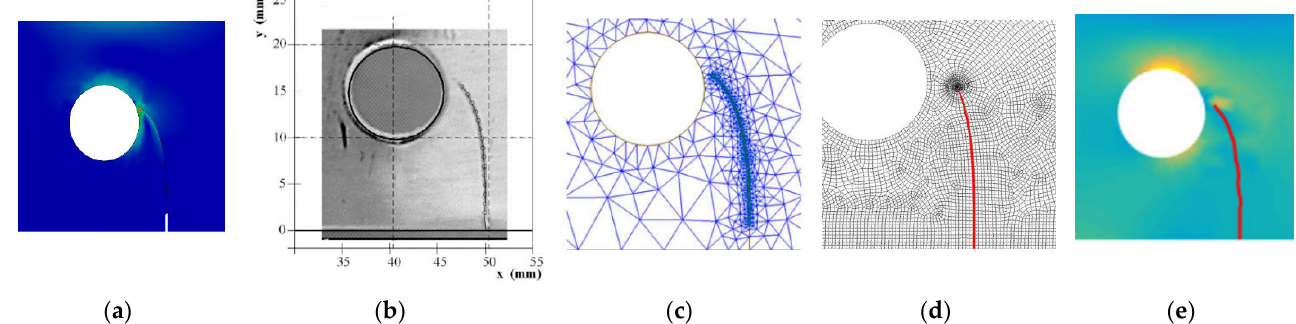
Figure 3. Comparison of the crack growth trajectory for the four-point bending beam; ( a ) present study; ( b ) experimental observation reproduced from [23] with permission from Elsevier 2003; ( c ) numerical reproduced from [24] with permission from Elsevier 2010; ( d ) numerical reproduced from [25] with permission from Elsevier 2017; ( e ) numerical reproduced from [26] with permission from Elsevier 2020.